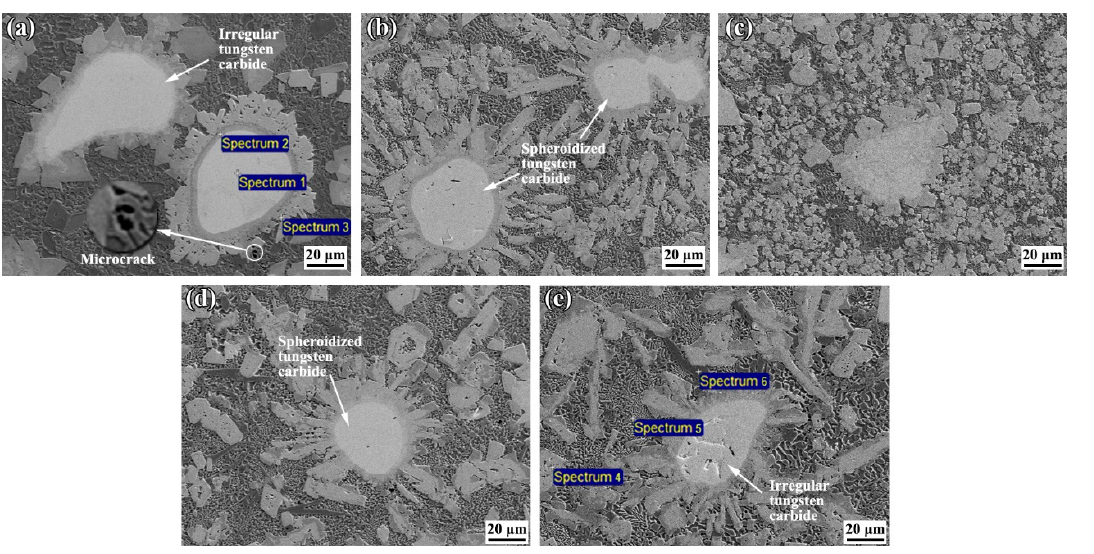
Figure 4. Morphologies of tungsten carbide particles and its surrounding in the cladding layer under different CeO 2 contents: ( a ) 0 wt.%CeO 2 , ( b ) 0.1 wt.% CeO 2 , ( c ) 0.2 wt.% CeO 2 , ( d ) 0.5 wt.% CeO 2 , and ( e ) 1.0 wt.% CeO 2 . Table 2. EDS analysis results of Ni-based tungsten carbide cladding layer under different CeO 2 contents in Figure 4 (wt.%).